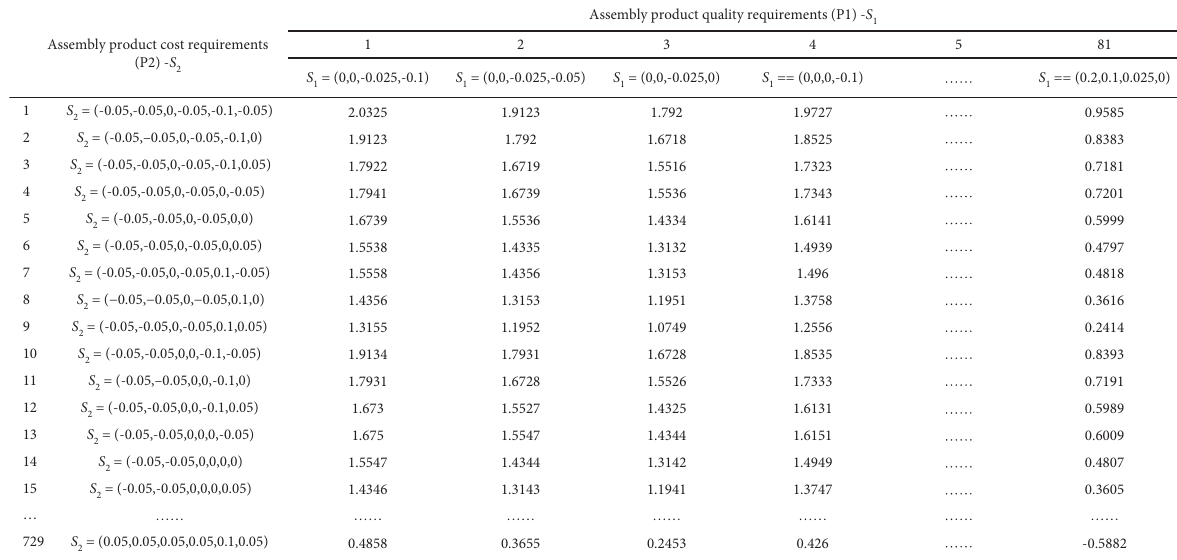
Figure 9: The game utility matrix of alliance {P1, P2}. Table 1: The solution and comparative analysis of the optimization model of steam turbine tolerance distribution. Optimization